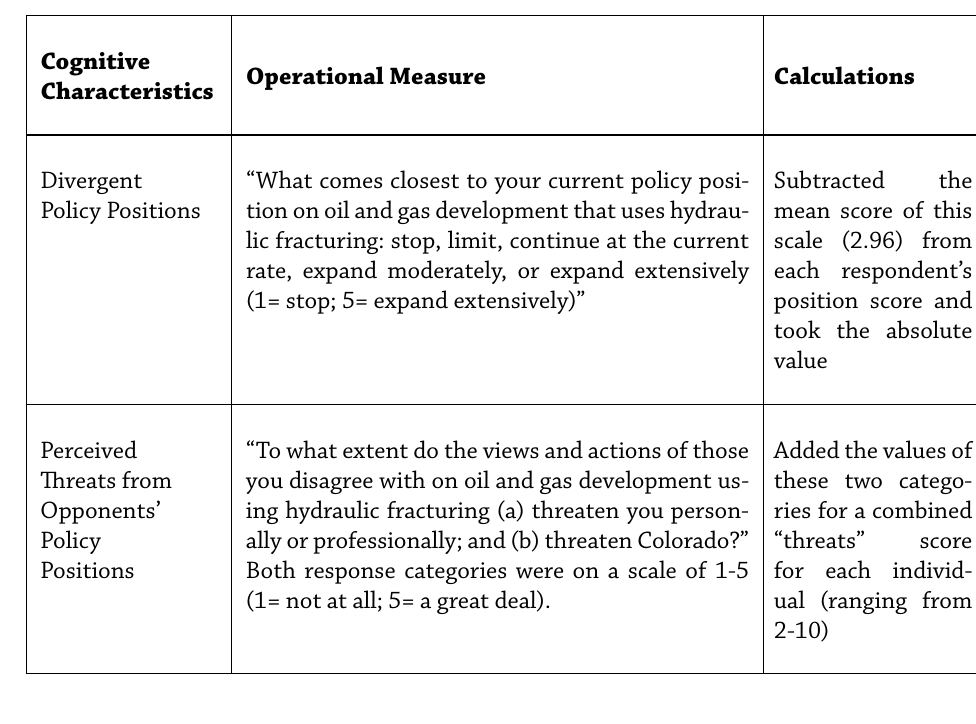
Table 1. Operationalization of the Characteristics of Policy